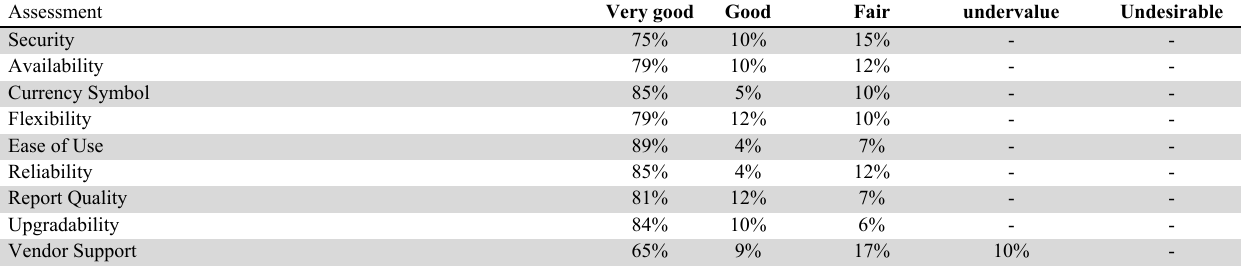
Respondents Frequency of Assessment Factors